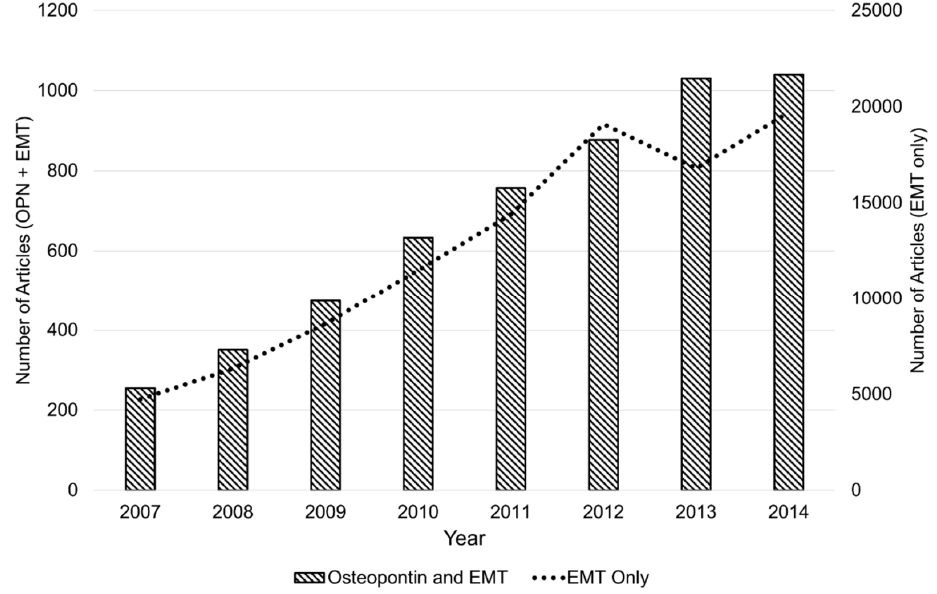
Figure 1. The appearance of “osteopontin” and epithelial-mesenchymal transition in the same peer-reviewed scientific article over time (per year), beginning in 2007. Data on number of articles obtained using Google Scholar search with terms “osteopontin (OPN) + epithelial-mesenchymal transition (EMT)” vs. “EMT” only, excluding patents and citations.